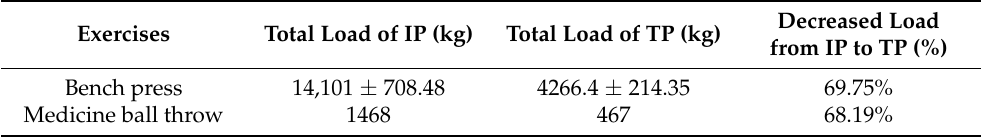
Table 3. Quantification of the volume load in the intervention and taper